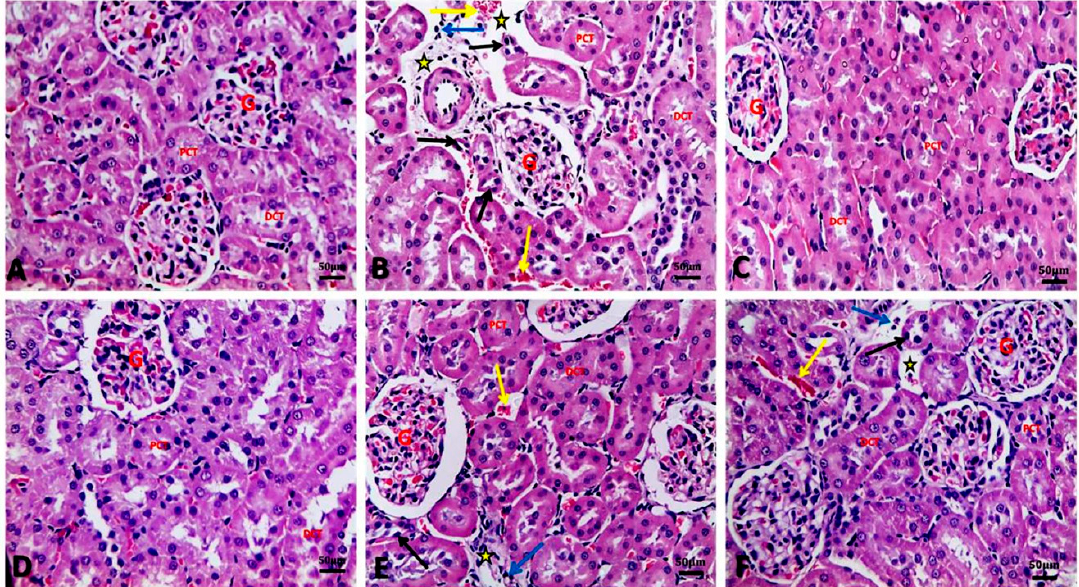
Figure 3. Representative photomicrographs of histopathological alterations in kidney sections of di ff erent groups (H&E stain X 20 ; scale bar 50 µ m; star: edema, yellow arrow: congestion, black arrow: tubular atrophy with nuclear pyknosis, blue arrow: inflammatory cell infiltration, G: glomeruli, PCT: proximal convoluted tubules, DCT: distal convoluted tubules). ( A ) Control group showing normal architecture of kidney glomeruli and renal tubules (proximal and distal convoluted tubules) with intact well organized cellular boundary. ( B ) BM group showing perivascular edema and congestion in the interstitial tissue in between renal tubules, atrophied proximal renal tubules with nuclear pyknosis, and inflammatory cell infiltration. ( C ) AO / 0.5 and ( D ) AO / 1 showing normal architecture of glomeruli and renal tubules as control group. ( E ) BM + AO / 0.5 group and ( F ) BM + AO / 1 group showing mild congestion, mild edema, and mild nuclear pyknosis of some renal tubular cells and mild inflammatory cell infiltration in the interstitial tissue.